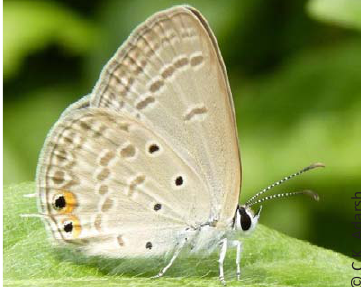
Image 66. Acytolepis puspa Common Hedge Blue.